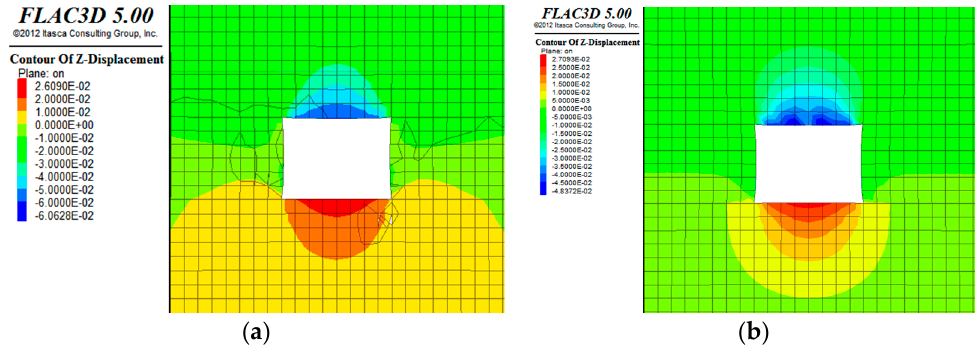
Figure 10. Nephogram of the roof subsidence with or without bolt support. ( a ) Without bolt support; ( b ) With bolt support.